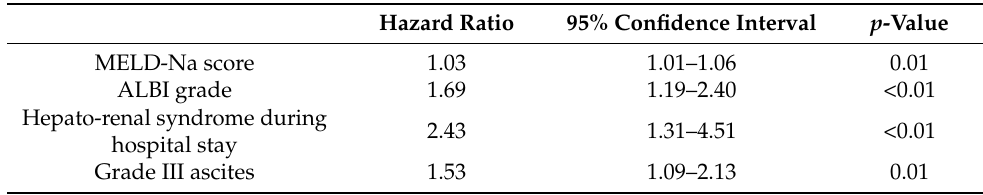
Table 5. Multivariate Cox proportional hazards model in the hepatic hydrothorax